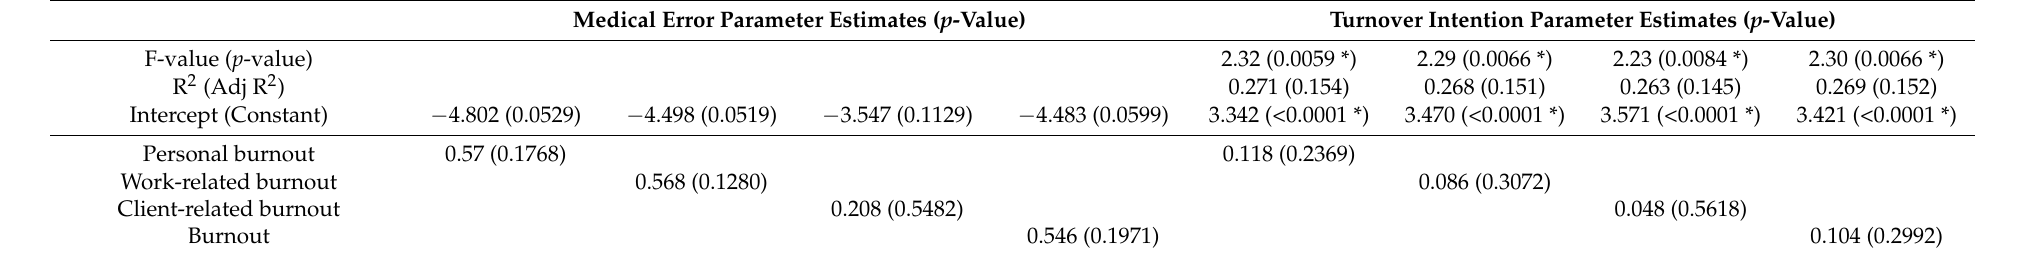
Table 4. Influence of burnout on turnover and medical error ( N =